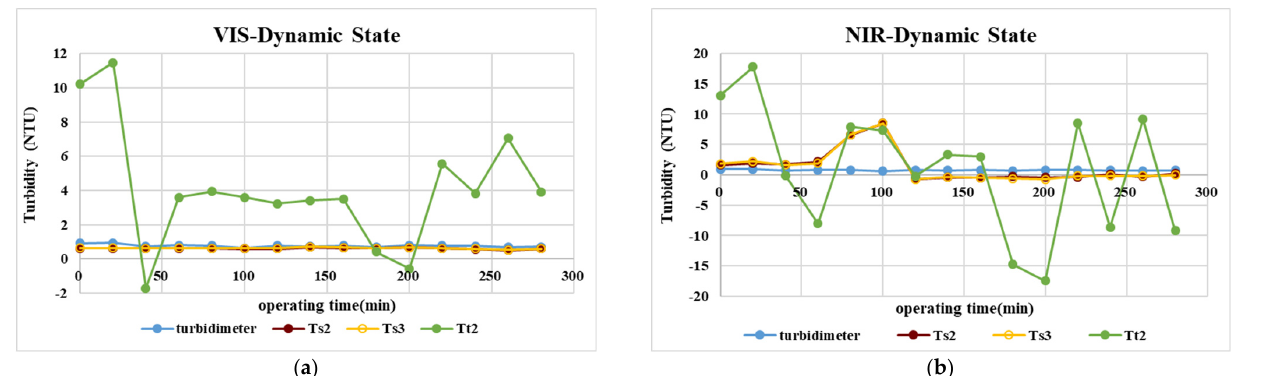
Figure 7. Continuing monitoring results of tap water turbidity verified by different algorithm models. ( a )VIS. ( b )NIR. Table 7. Statistics of average error for continuing monitoring of tap water turbidity verified by different lighting sources.